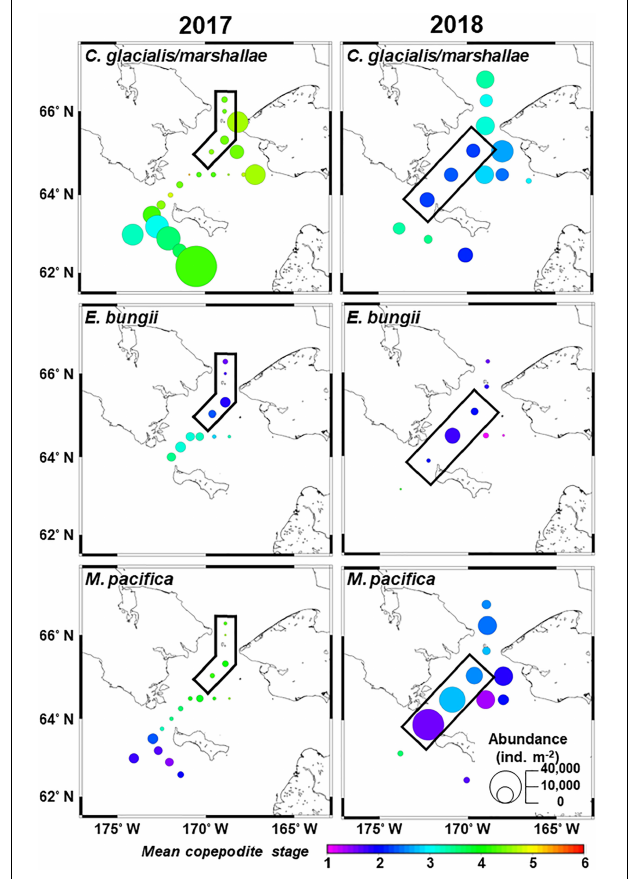
FIGURE 7 | Horizontal distribution of dominant large copepods in the northern Bering Sea during July 2017 (left) and 2018 (right) . The circle size and color denote the abundance and mean copepodite stage of each species. The black frames indicate the stations identified as group E, as demonstrated by Bray–Curtis similarity analyses based on zooplankton abundance (cf. Figure 4